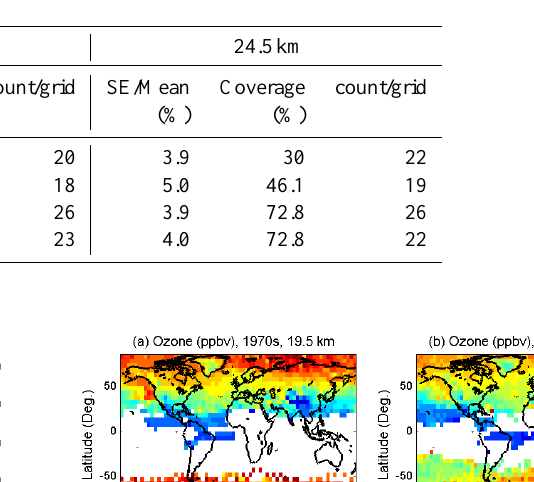
Table 5. Standard error of the mean (SE/mean, in %), coverage (in % of the total grid cells), and the number of samples per grid (in count/grid) by decade at 19.5 and 24.5km, respectively.